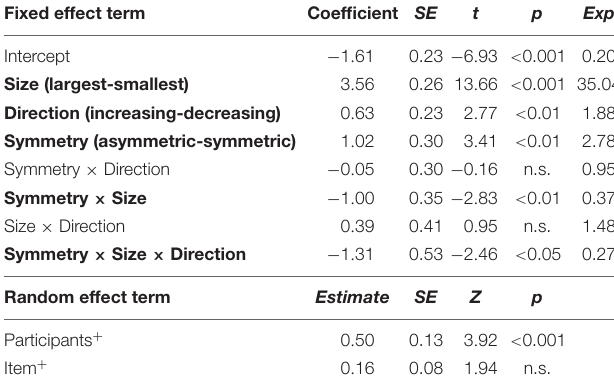
TABLE 2 | Fixed effects analysis for experiment